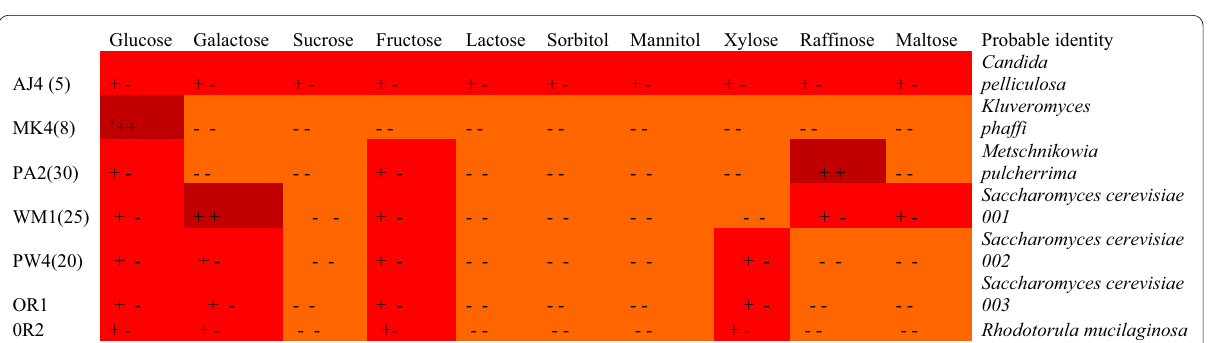
Fig. 1 Sugar fermentation and probable identity of yeast